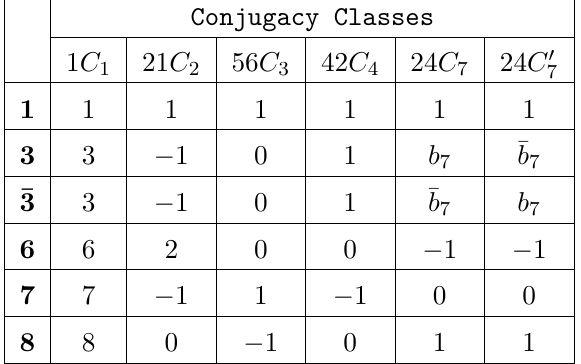
p = (cid:0) (1+ i 7) = 2. 7